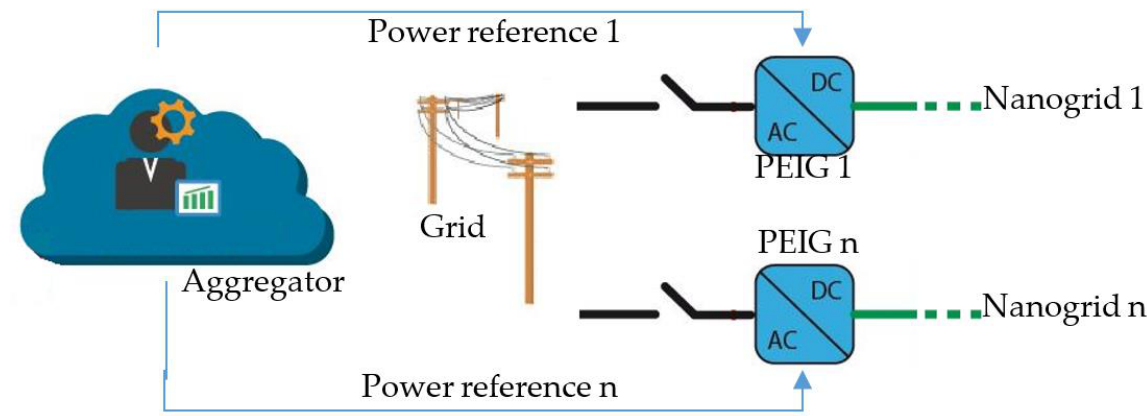
Figure 2. Power references sent by the aggregator to PEIGs of nanogrids belonging to the community.